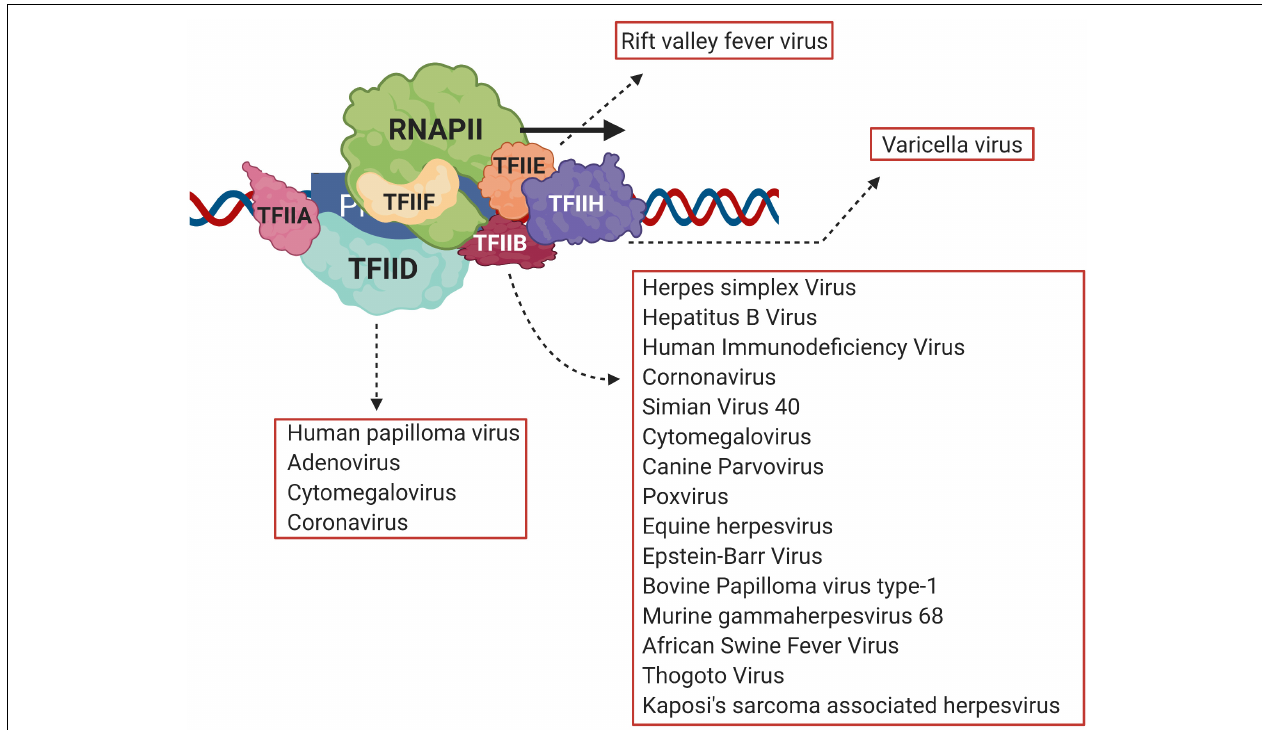
FIGURE 1 | Viral transcriptional regulators target different general transcription factors, but TFIID and TFIIB are the prime targets. Viruses target general transcription factors such as TFIIB, TFIID, TFIIE and TFIIH in order to transcribe viral genes. TFIIB, however, is emerging as the most common target of many different viruses such as HIV, HSV, HCMV and HBV among others. Created with